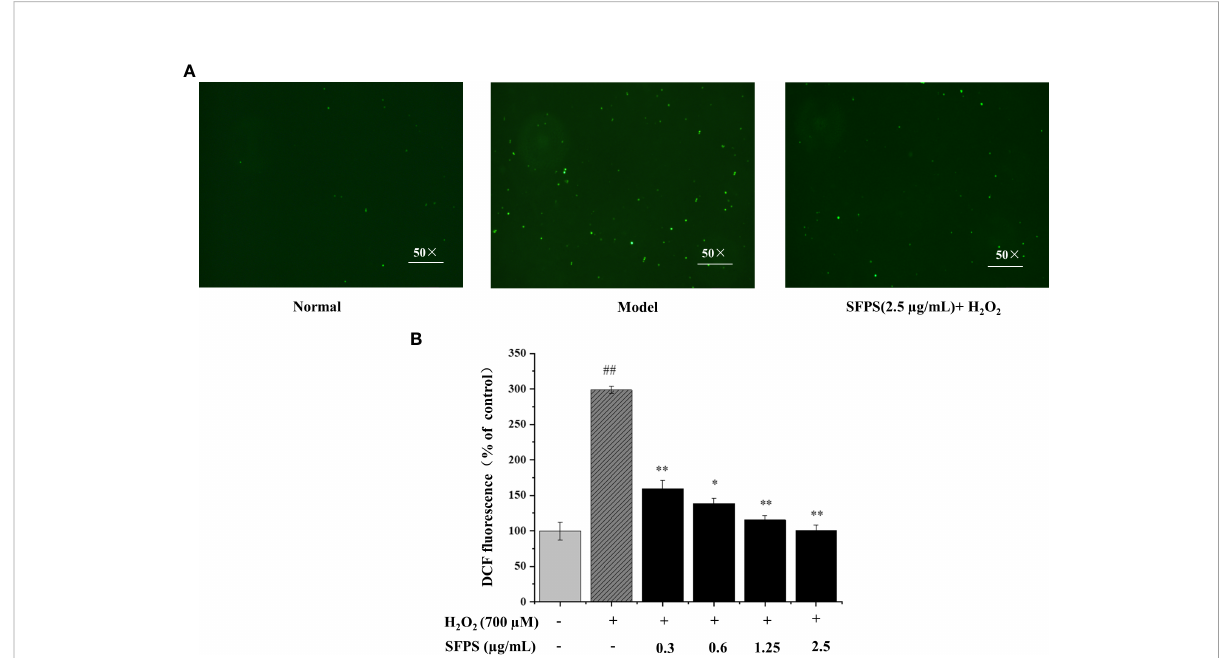
FIGURE 6 Effect of SFPS pretreatment on intracellular reactive oxygen species (ROS) in H 2 O 2 -induced LO2 cells. (A) The fl uorescence intensity of DCF image of cells after treatments as examined by fl uorescence microscopy (magni fi cation 50×). LO2 cells were incubated with 2.5 µg/mL SFPS for 12 h and then treated with 700 µM H 2 O 2 for 3 h. (B) Effect of SFPS on DCF fl uorescent density of H 2 O 2 -treated LO2 cells. DCF fl uorescent density was observed by the ROS assay kit. p < 0.01 (**) or p < 0.05 (*) indicates that the columns of H 2 O 2 group and SFPS groups are signi fi cantly different. p < 0.01 (##) indicates signi fi cant difference between the control group and the H 2 O 2